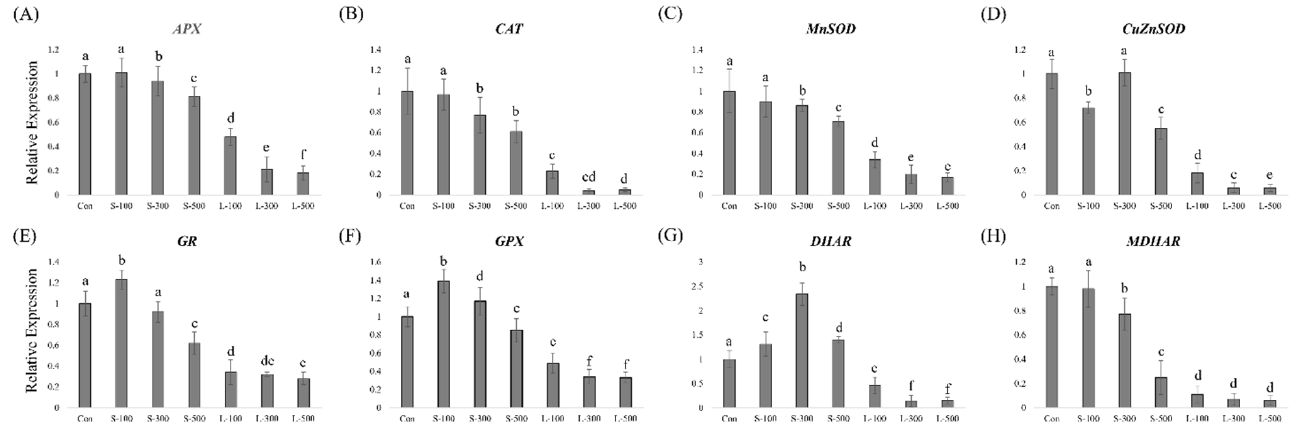
Figure 6. Antioxidant-related gene expression profiling in wheat seedlings determined by RT-qPCR. ( A ) APX , ( B ) CAT , ( C ) MnSOD , ( D ) CuZnSOD , ( E ) GR , ( F ) GPX , ( G ) DHAR , and ( H ) MDHAR . RT-qPCR was performed with three biological replicates, and each bar represents the mean ± SD ( n = 10). Values with different letters are significantly different using Duncan’s multiple range test ( p < 0.05).